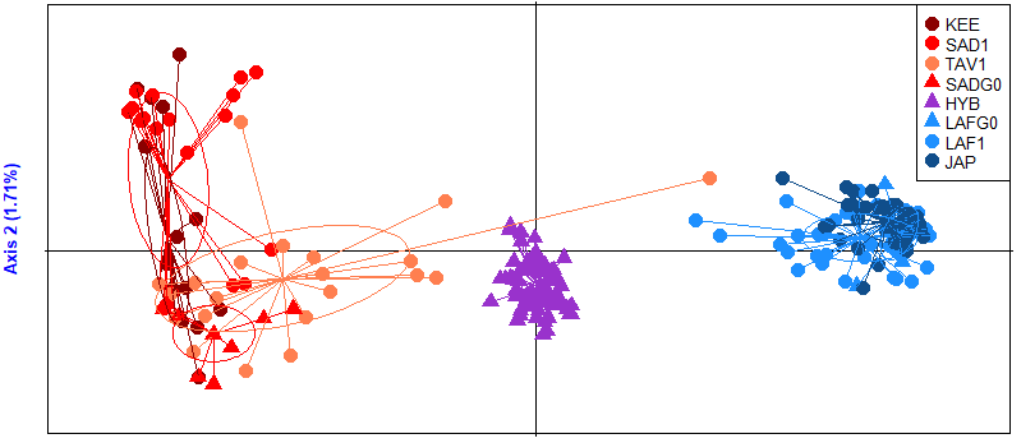
Figure 3. Discriminant analysis of principal components (dAPC) representation of the eight populations / progeny of cupped oysters, with C. angulata from Asia (KEE, dark red) and Europe (SAD1, TAV1, and SADG0, red), C. gigas from Asia (JAP, dark blue) and Europe (LAF1, LAFG0, blue), and experimental hybrids (HYB, violin). Natural populations (KEE, SAD1, TAV1, LAF1, JAP) are presented with a dot whereas G0 parents (SADG0, LAFG0) and experimental hybrids (HYB) are presented with a triangle.